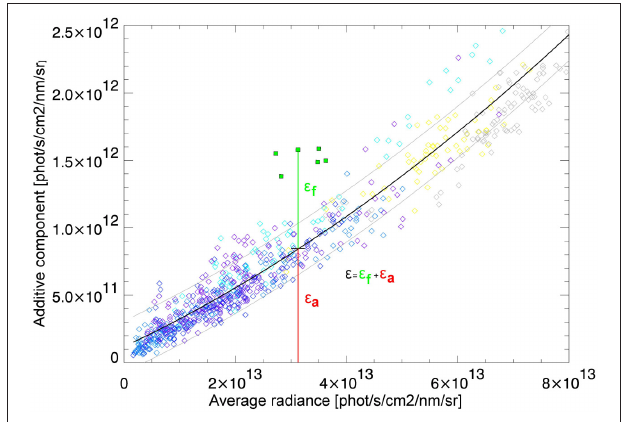
FIGURE 2 | The additive component ε as a function of the average radiance ¯ I m (see Equation 18): green symbols, in presence of vegetation; blue, over open ocean; gray, over permanent land ice; yellow, over desert; black solid line is the fitted curve; gray solid lines are ± σ standard deviation curves. All shown retrieval results in absence of vegetation might be affected by cloudiness.